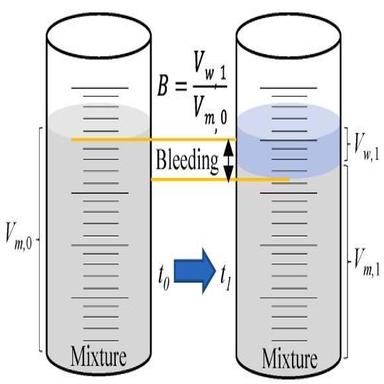
Bleeding test of freshly mixed cementitious mixtures.